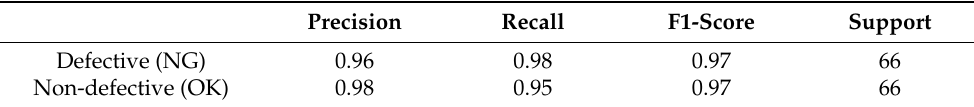
Table 2. Validation results of algorithm for screening coating defects. Precision Recall F1-Score